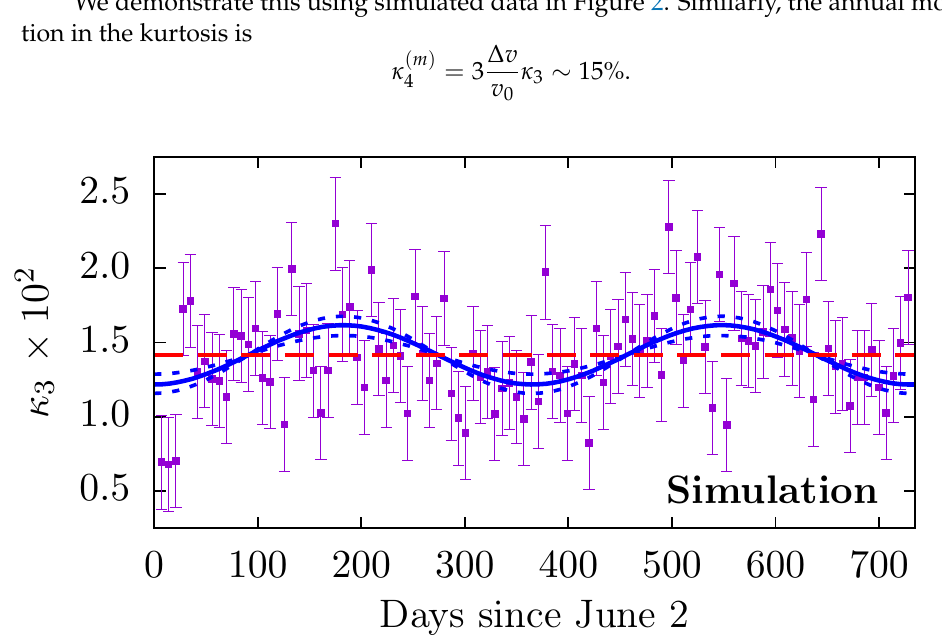
Figure 2. Simulation for two years of data ( τ 0 = 1s), with DM signals ( R 0 τ 0 = 0.01, χ 0 / σ = 1) including the annual velocity modulation [62]. The skewness is calculated for each week of data (purple squares, with √ 6/ N error bars). The extracted modulation amplitude is κ ( m ) 10 − 2 (23). The solid blue curve is the best-fit cosine, and the dotted lines are the uncertainties. The dashed red curve shows the mean κ 3